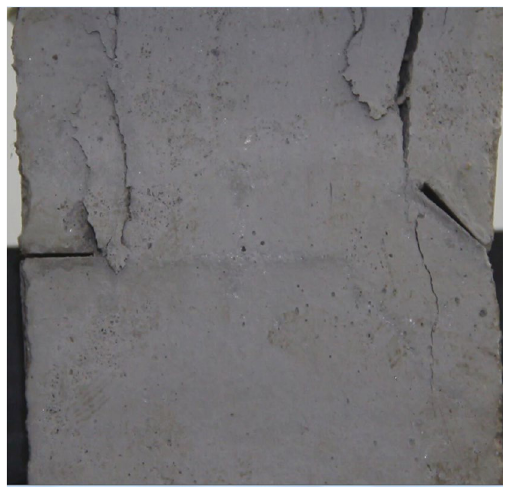
Figure 55. Photograph of a specimen showing anti-tensile wing crack.